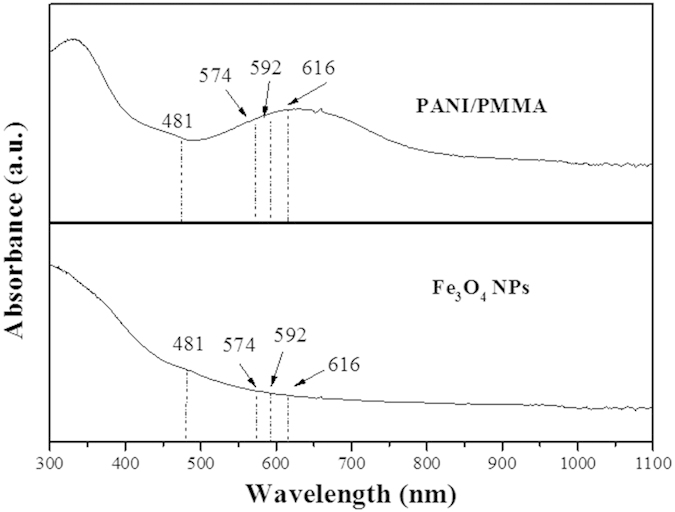
Ultraviolet-visible absorption spectra of PANI/PMMA and Fe3O4 NPs.